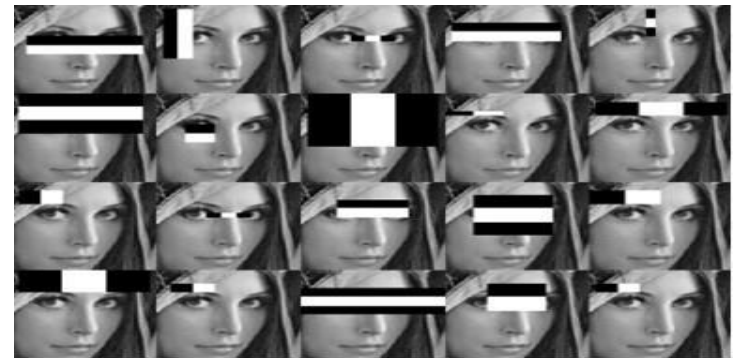
Figure 7. Haar-like features for face detection